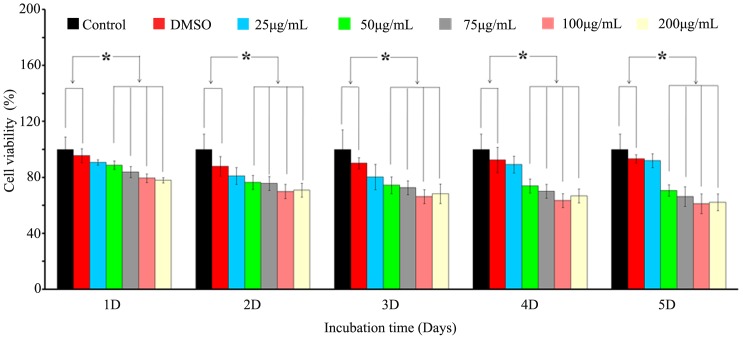
The effect of 20(S)-Rg3 on hypertrophic scar fibroblast viability.Data are expressed as the mean ± SD of triplicate experiments. * p<0.05 is considered to be significantly different compared to the control, as determined by the two-tailed Student's t-test.